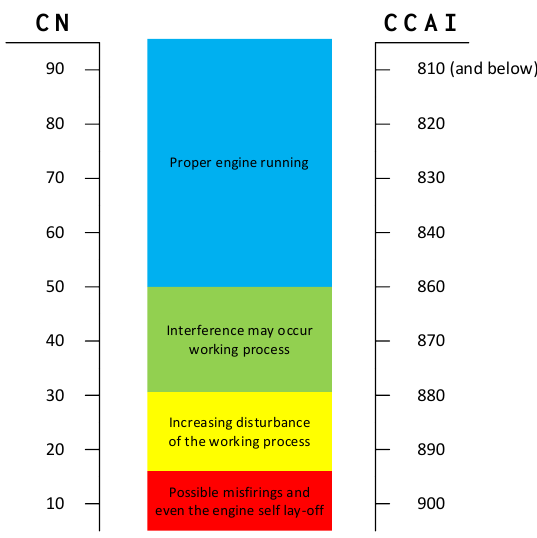
Fig. 7. Nomogram for the estimation of an impact of the self-ignition capacity indicators for marine fuels: distillate (CN) and residual (CCAI) on the functioning a marine